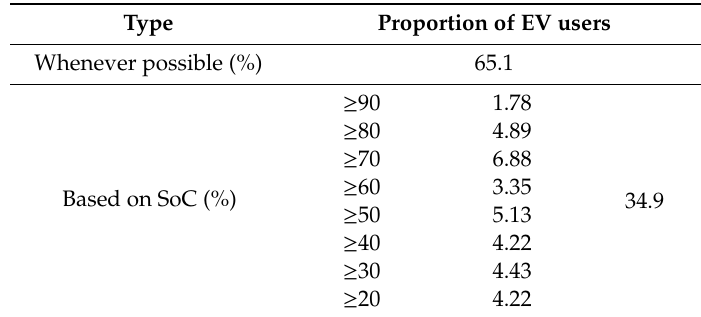
Table 13. The charging types of EV users.